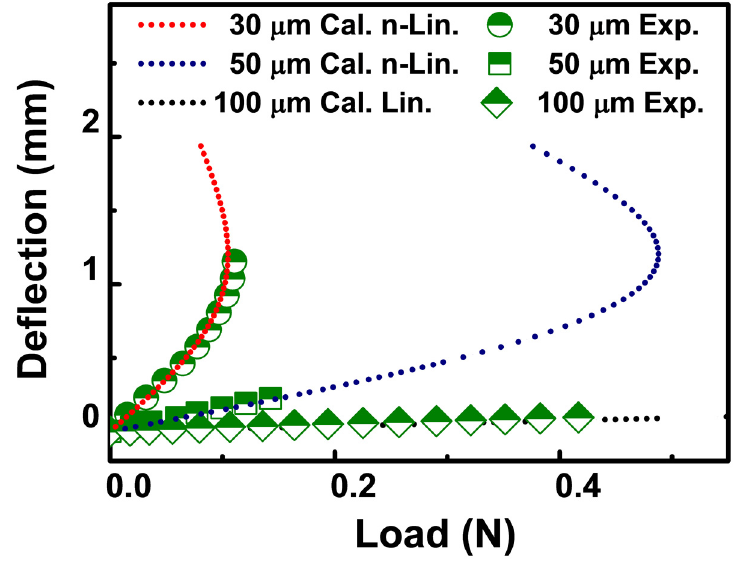
Figure 6. Deflection versus applied load plot for various thicknesses of flexible substrates, dotted lines showing non-linear analytical solution for 30 and 40 µ m thick substrates and linear analytical solution for 100 µm thick substrates. Adapted courtesy of Prof.